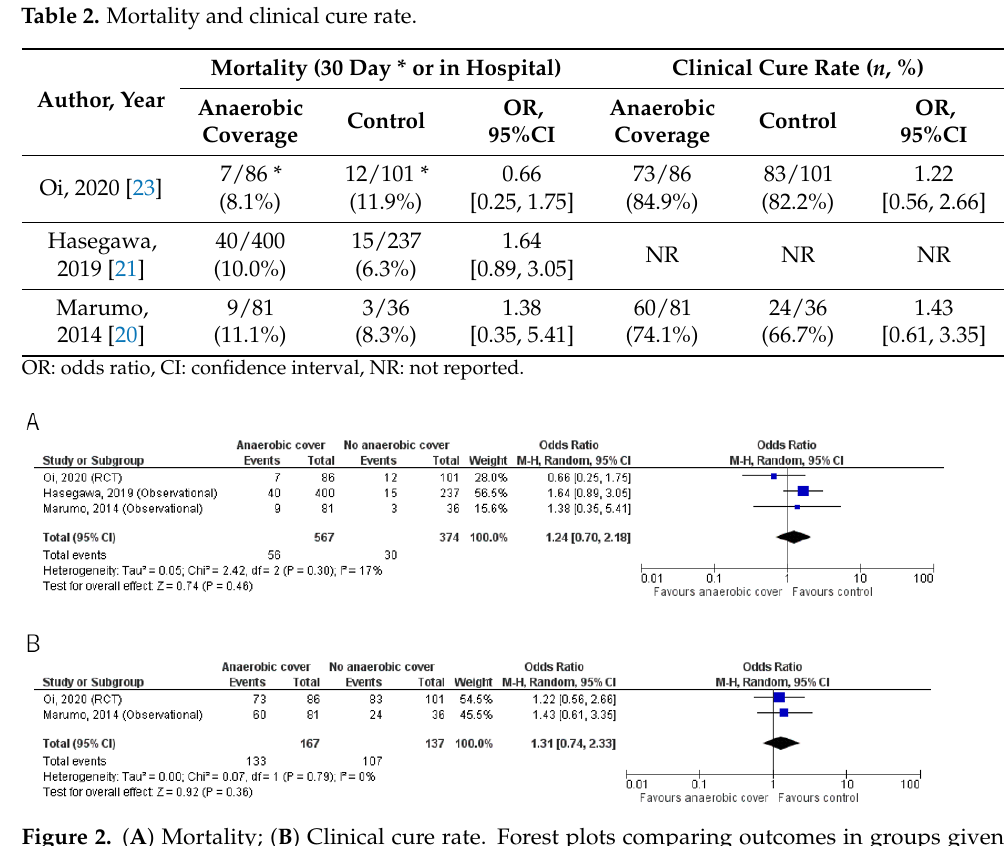
Figure 2. ( A ) Mortality; ( B ) Clinical cure rate. Forest plots comparing outcomes in groups given antibiotic treatment with or without anaerobic coverage. The blue square represents the odds ratios of individual studies. The black diamond represents the pooled result [20,21,23].